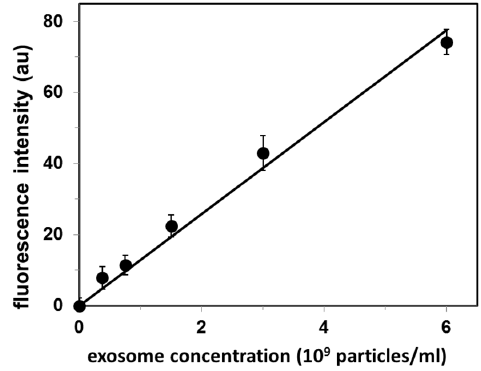
Figure 2. Calibration curve for quantification of exosomes isolated from fetal bovine serum (FBS). Values are mean ± SE of 3 independent experiments. Fluorescence intensity is in arbitrary units (au).